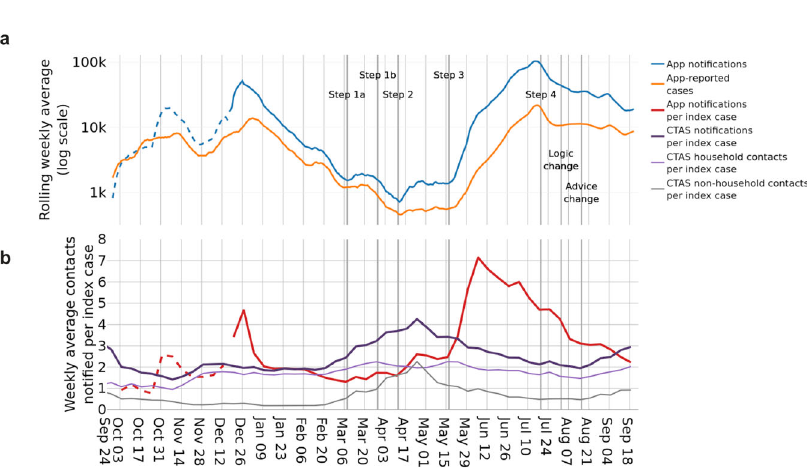
Fig. 4| Noti fi cationsandpositivetestsviadigitalandmanualtracing.a Weekly rolling averagesof app-reported casesand the noti fi cationsthey trigger,shownon a logarithmic scale. b Weekly averages of contacts noti fi ed per index case via the app and via manual tracing (as recorded by CTAS). CTAS contacts are also shown disaggregated by whether they are household or non-household contacts; the household status of some contacts is not recorded so these values do not always sumtothetotalnumberofCTASnoti fi cationsperindexcase.Theoverlapbetween